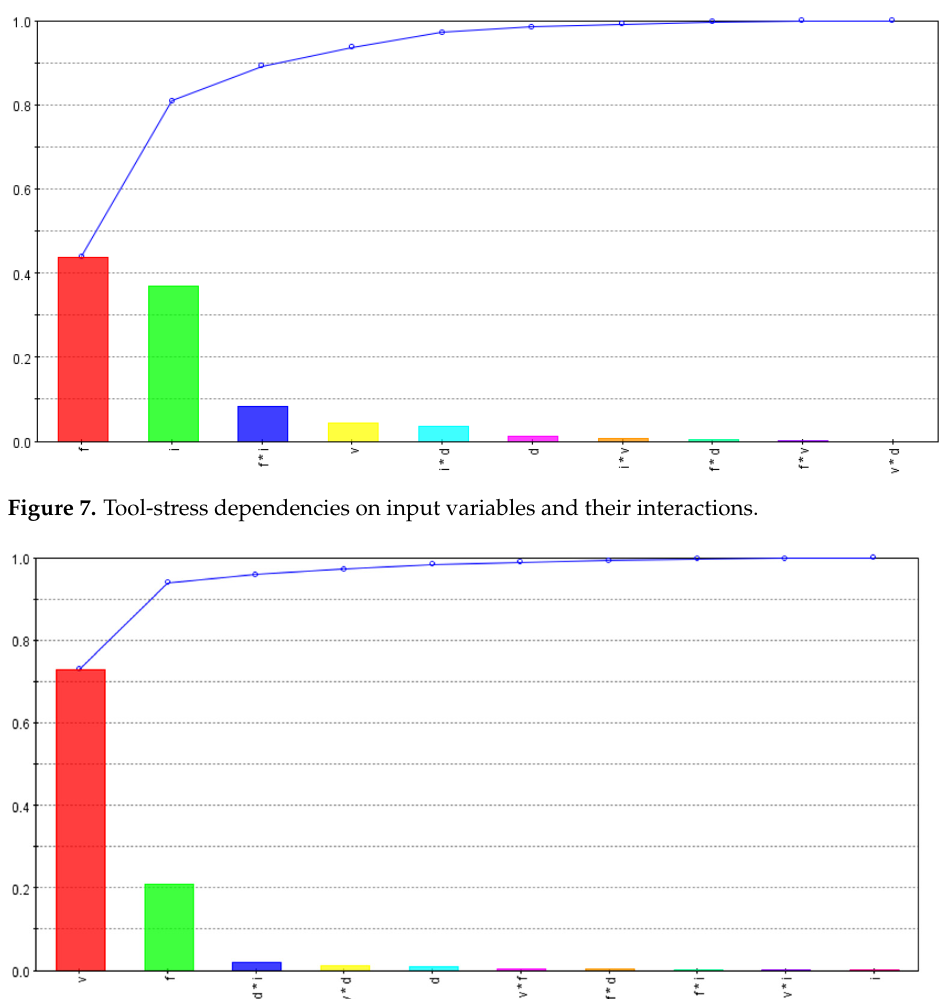
Figure 8. Tool-temperature dependencies on input variables and their interactions.